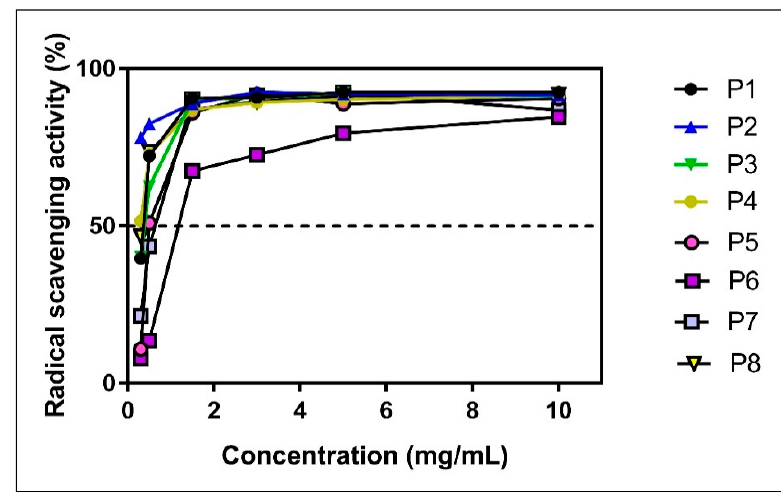
Figure 4. Concentration-dependency of radical scavenging activity of propolis samples (DPPH assay).